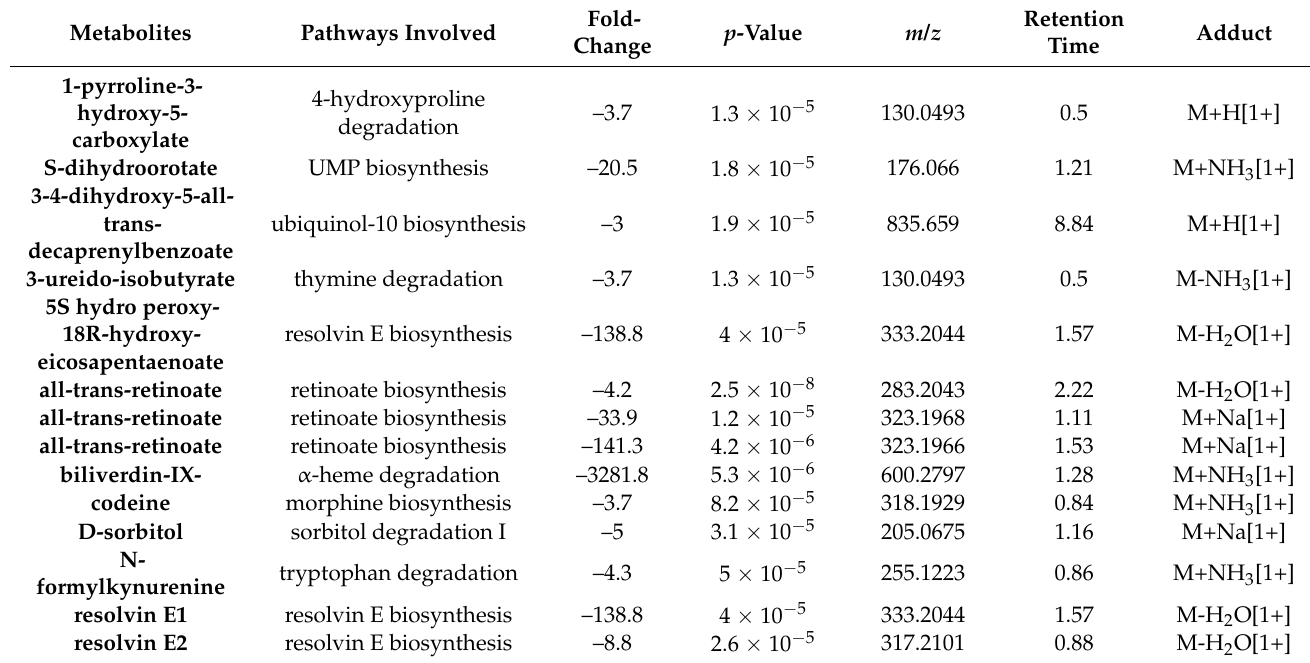
Table 2. Metabolites significantly downregulated after 24 h safranal treatment in media extracts involved in critical metabolic